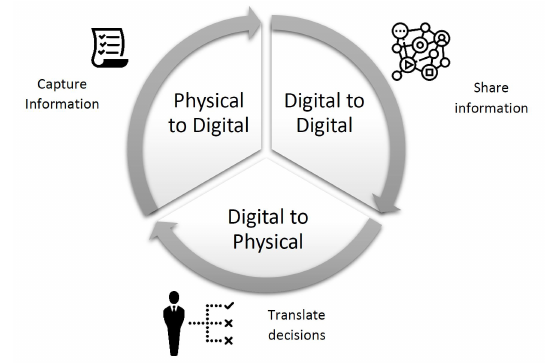
Figure 9. Digital Supply Chain